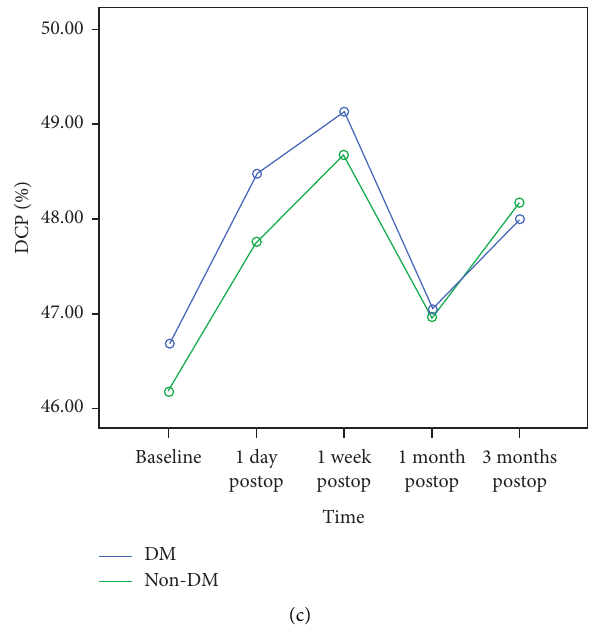
Figure 1: The changes in MT, SCP, and DCP after cataract